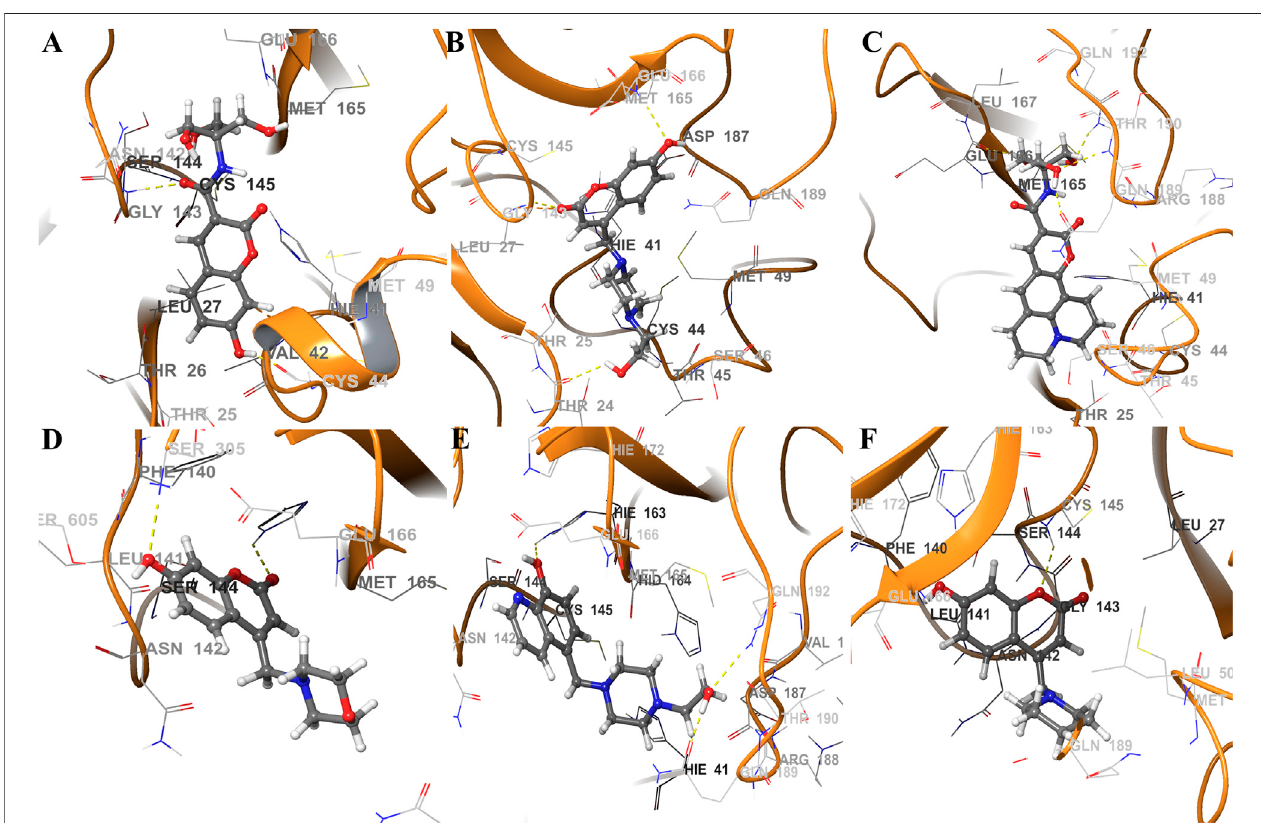
FIGURE 7 | Schematic representations of main component analysis of their respective production run for ligands (A) CTR9, (B) 7HC6, (C) CTR6, (D) 7HC3, (E) 8HQ6 and (F) 7HC5 bound to SARS-CoV-2 M pro . The surrounding amino acid residues in the binding pocket of SARS-CoV-2 M pro within 3Å from ligands. The yellow dotted line usually represents intermolecular interactions, like hydrogen